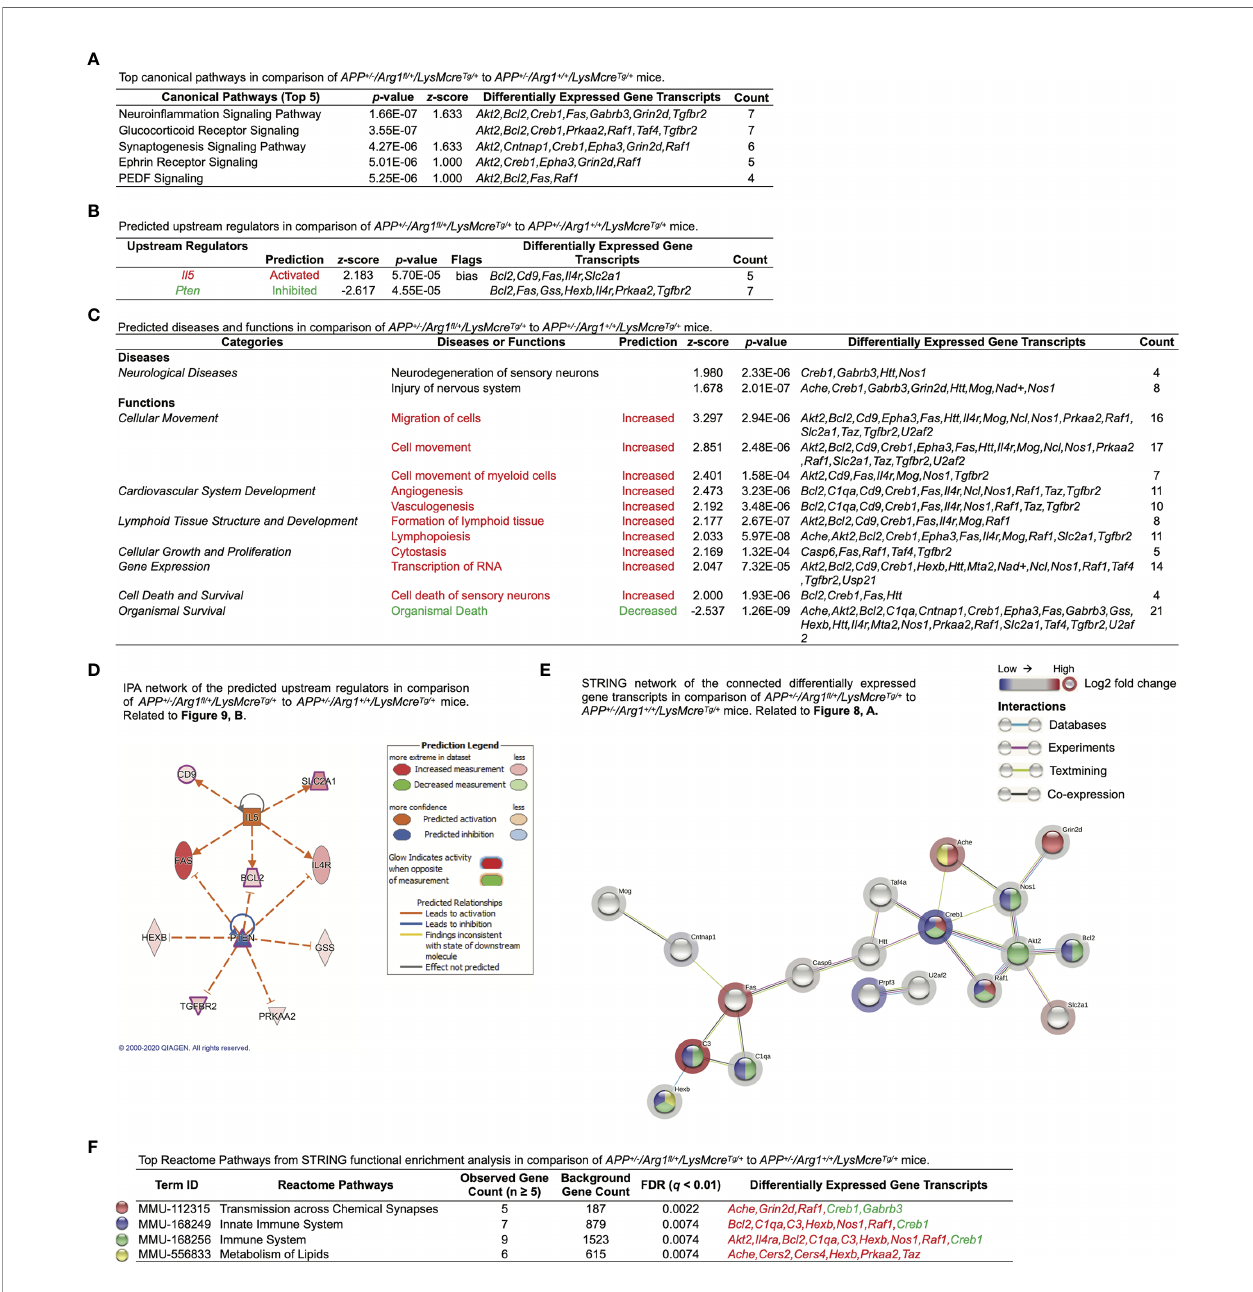
FIGURE 9 | Ingenuity Pathway Analysis and STRING network analysis of LysMcre dependent Arg1 haploinsuf fi ciency in mouse brain with amyloidosis. Differentially expressed gene transcripts (DEGs, p < 0.05) created by comparing APP +/- /Arg1 fl /+ /LysMcre Tg/+ to APP +/- /Arg1 +/+ /LysMcre Tg/+ mice were analyzed by Ingenuity Pathway Analysis (IPA) and STRING network analysis using publicly available databases. (A) A table lists the top fi ve canonical pathways (based on p -values). (B) A table lists the top predicted upstream regulators (based on z -scores). (C) A table lists the top predicted diseases and functions under different categories (based on z -scores). An absolute z -score value at 2.0 was set as the cut-off criterion to predict the activated/increased ( z -score > 0) or inhibited/decreased ( z -score < 0) states and were highlighted in red or green. (D) IPA network displays the predicted upstream regulators in a hierarchical order. Upstream regulators predicted as activation or inhibition are colored in orange or blue. DEGs are colored in red or green, indicating increased or decreased expression. DEGs involved in Alzheimer ’ s disease are also highlighted with a purple border. Direct or indirect gene interactions are in solid or dash lines with orange or blue colors indicating activation or inhibition. The intensity of color shading represents either measured fold-change magnitude or predicted activation/inhibition magnitude. (E) STRING network of the connected DEGs is presented. Each node represents a DEG with a halo color of red to blue, indicating high to low values of log2 fold-change. Nodes in different colors are annotated based on the top Reactome Pathways. Each edge line represents an interaction between two DEG transcripts based on parameters of databases (cyan), experiments (purple), textmining (yellow), and co-expression (black). (F) A table lists the top Reactome Pathways from STRING functional enrichment analysis. The false discovery rate (FDR) q -value is set at ≤ 0.01. The observed gene count is set at ≥ 5. Gene transcripts highlighted in red or green indicate up or down expression. n=3 samples per group representing 6